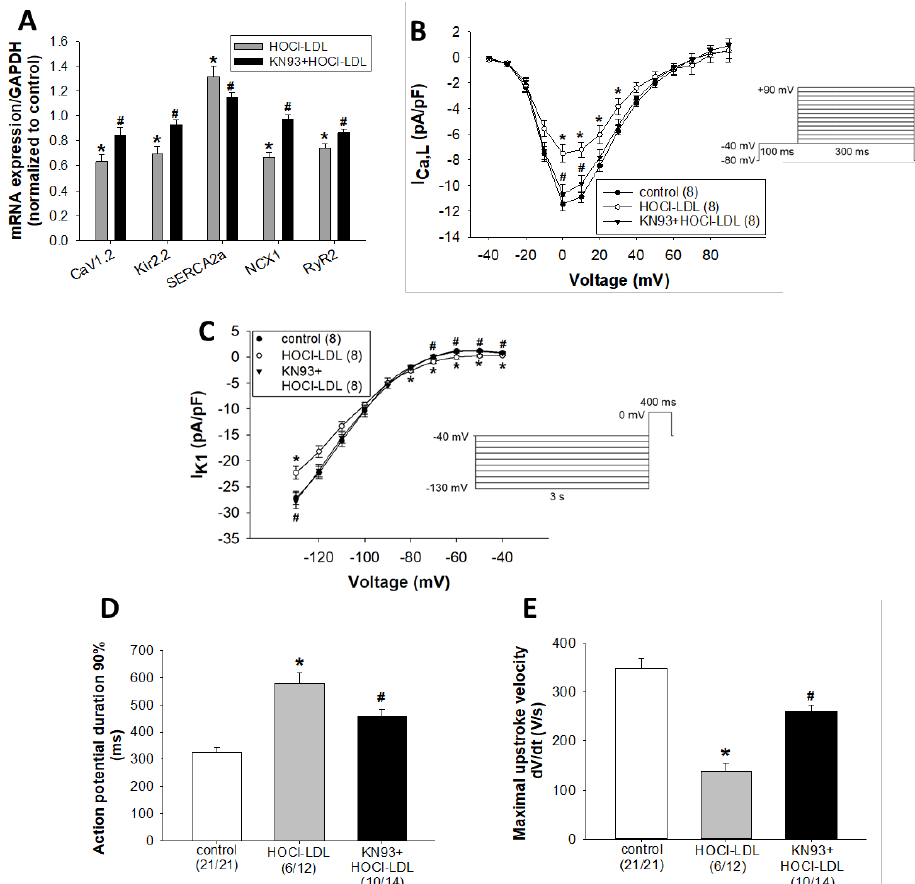
Figure 3. HOCl-LDL modulates the expression of ion channels/pumps, and reduces I Ca,L as well as I K1 densities via CaMKII oxidation. ( A ) mRNA expression of indicated ion channels/pump in HL-1 cardiomyocytes incubated with HOCl-LDL (oxidant:lipoprotein molar ratio of 200:1, 250 µg/mL, 12 h) in the absence or presence of KN93 (5 µM, added 30 min prior to HOCl-LDL) ( n = 6). ( B ) I Ca,L and ( C ) I K1 density (the voltage clamp protocols are illustrated in the respective insets), ( D ) APD at 90% repolarization, and € maximal upstroke velocity of GPV cardiomyocytes incubated with (B,C) HOCl-LDL (oxidant:lipoprotein molar ratio of 200:1) or ( D , E ) HOCl (400:1, 250 µg/mL, 12 – 16 h, 1 Hz stimulation frequency) in the absence or presence of KN93 (5 µM, added 30 min prior to addition of HOCl-LDL). Values are expressed as mean ± SEM. ( n ) represents the number of ( A ) experiments or ( B , C ) cardiomyocytes, and ( D , E ) (n/n) represents the number of myocytes showing stimulated APs/total number of patched myocytes. Cardiomyocytes showing arrhythmic events were excluded from the analysis. * indicates p < 0.05 vs. control, # indicates p < 0.05 vs. HOCl-LDL. The reduced CaV1.2 expression led us to measure I Ca,L density and its voltage-de- pendence of steady-state activation and inactivation in GPV cardiomyocytes. In contrast